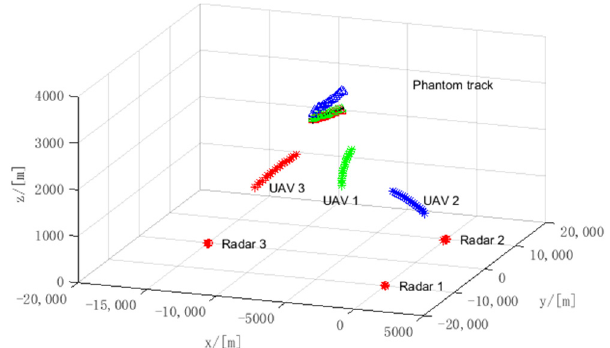
Figure 12. Phantom deception with radar location error and UAV position error (three UAVs).